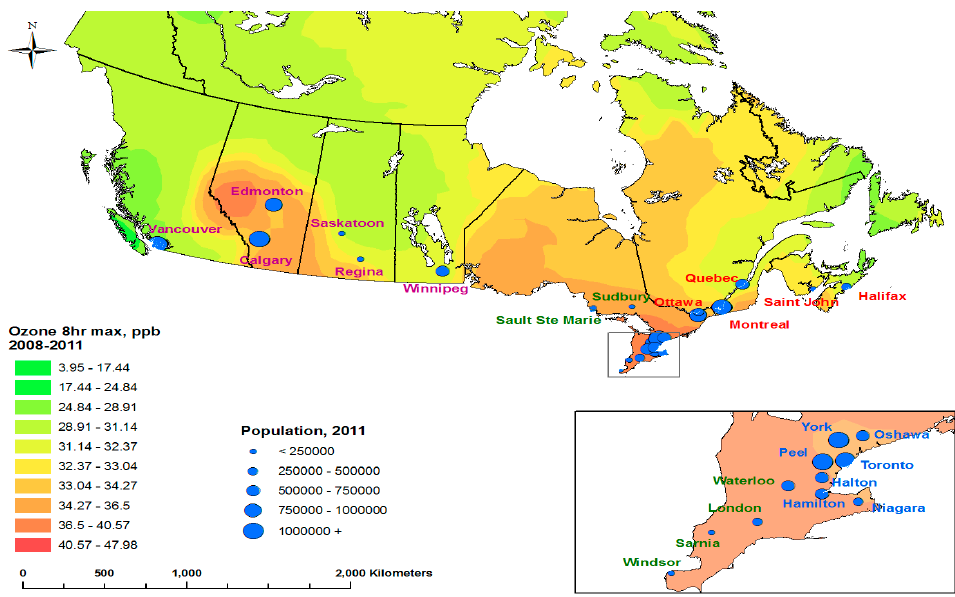
Figure 1. Selected Canadian Census Divisions with population size and spatially interpolated ozone concentrations.